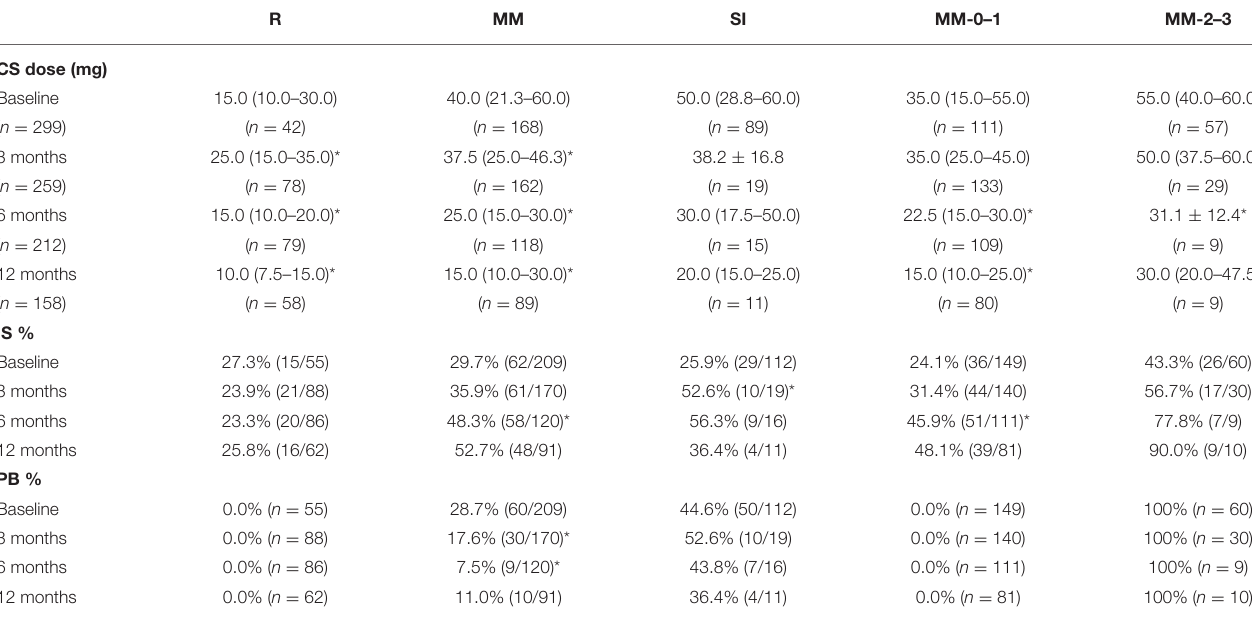
TABLE 3 | The CS dosage and proportion of patients with IS or PB in patients belonging to each real-time PIS category at baseline and each